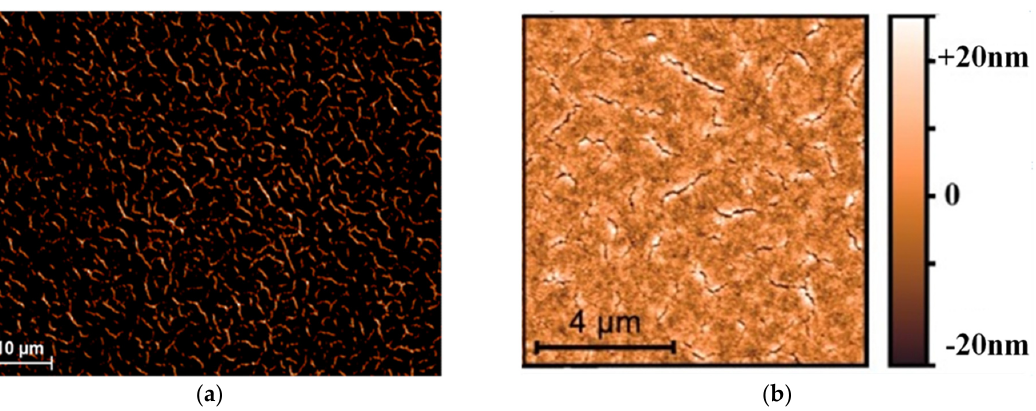
Figure 10. Example of crazing after ammonia curing seen through a dark field microscope ( a ) and measured by AFM ( b ).